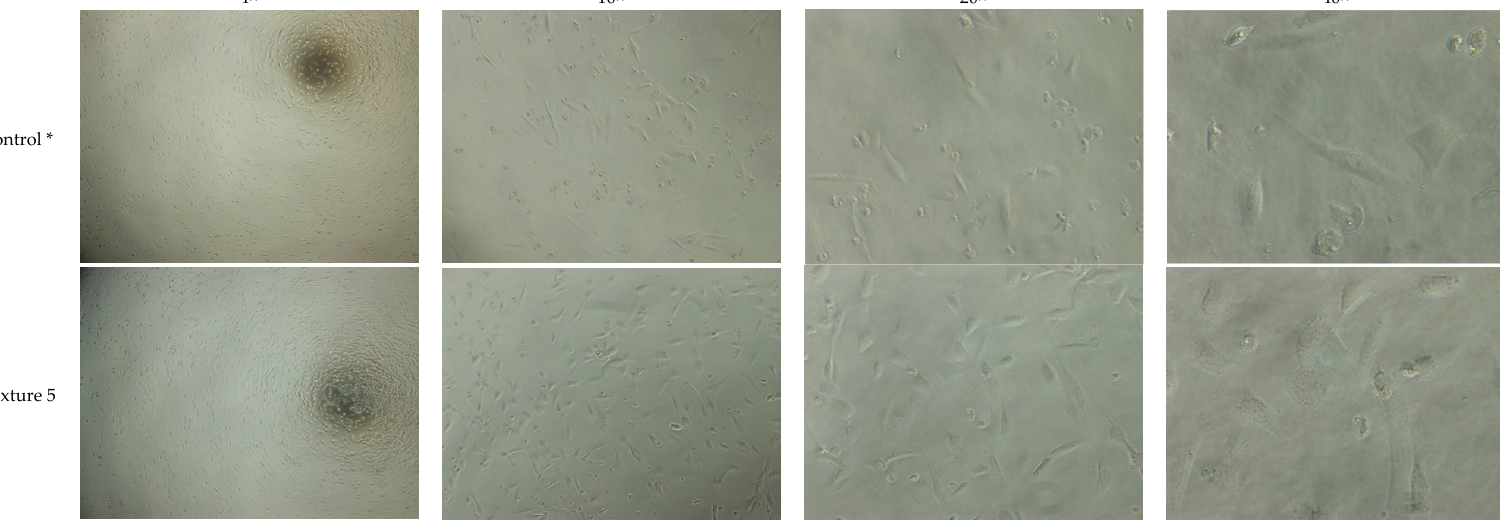
Figure 2. Light microscope images (4× magnification) of 1 and 3 days old cultured human OMECs on HA hydrogel scaffold mixture 5 dried for 1 or 2 days and coated with 1 mg/mL and 20 µg/mL collagen IV. OMECs showed improved attachment and morphology when the gelation/drying time of mixture 5 HA hydrogel was increased to two days. * Cultured human OMECs on coated plastic 24-well-plate with 1 mg/mL collagen IV.